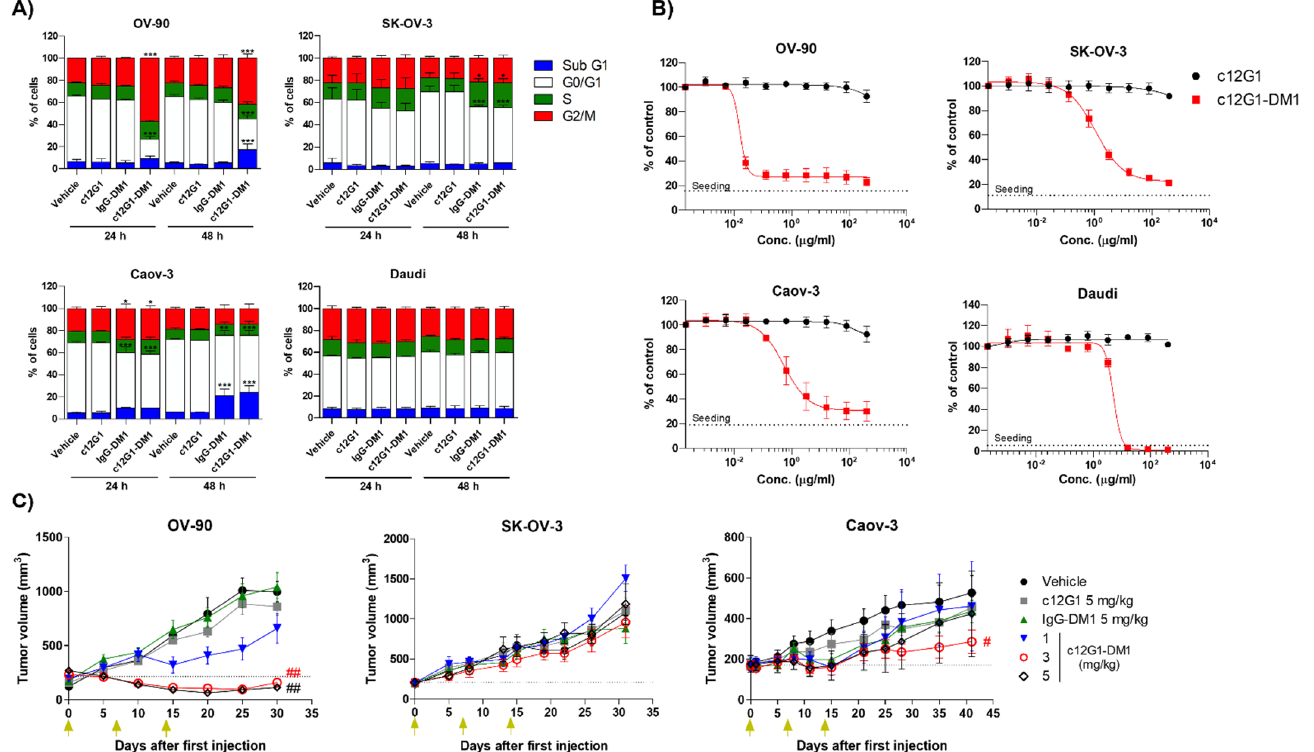
Figure 5. c12G1-DM1 exhibited anti-tumor activity, both in vitro and in vivo. ( A ) Ovarian cancer cells were treated with vehicle, c12G1 antibody (1 µg/mL), IgG-DM1 (1 µg/mL), or c12G1-DM1 (1 µg/mL), for 24 and 48 h. The cells were then fixed and stained with propidium iodide, followed by cell cycle analysis using a Celigo Imaging Cytometer (*, **, and ***, vs. their respective corresponding vehicle, c12G1, and IgG-DM1). c12G1-DM1 increased the cell population in the G2/M phase at 24 h, followed by an increase in the G1 population at 48 h. Daudi cells were used as the nectin-2-negative cell line. The results have been represented as mean ± SD from at least three independent experiments. ( B ) Cells were treated with serially diluted concentrations of the c12G1 antibody or c12G1-DM1, for 3–4 d. The cells were stained with 10 µM Hoechst 33342, at 37 °C for 30 min, and quantified using a Celigo Imaging Cytometer. The results represent mean ± SD of at least three independent experiments. The dashed line indicates the number of seeded cells. ( C ) Ovarian cancer cell lines were implanted into immunodeficient mice. The mice were randomized into different treatment groups when the tumor volume reached ~200 mm 3 (n = 6), and then intravenously administered vehicle, c12G1, IgG-DM1, or c12G1-DM1, as indicated. Green arrows indicate the administration of vehicle, c12G1, IgG-DM1, or c12G1-DM1 (# and ##, vs. their respective vehicle, c12G1, and IgG-DM1). * p < 0.01, ** p < 0.001, *** p < 0.0001, # p < 0.01, and ## p < 0.001.